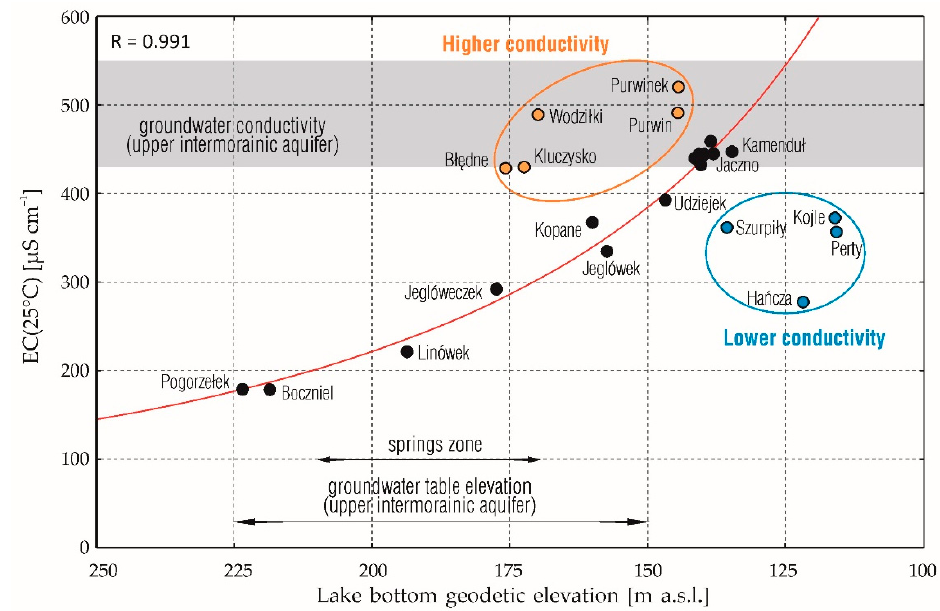
Figure 7. Influence of altitudinal location of lakes in a catchment on the mean conductivity of surface water in the SLP lakes.